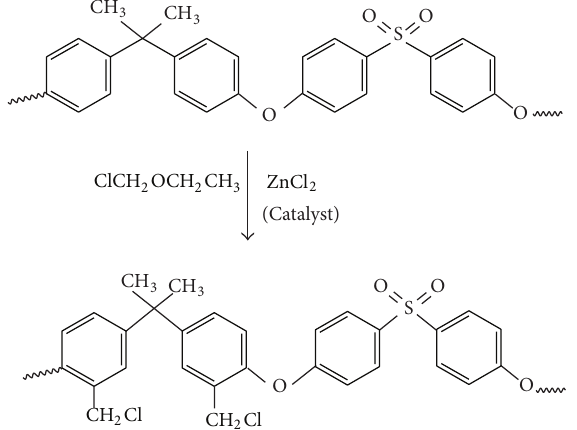
Scheme 1: Preparation of the chloromethylation of polysulfone.